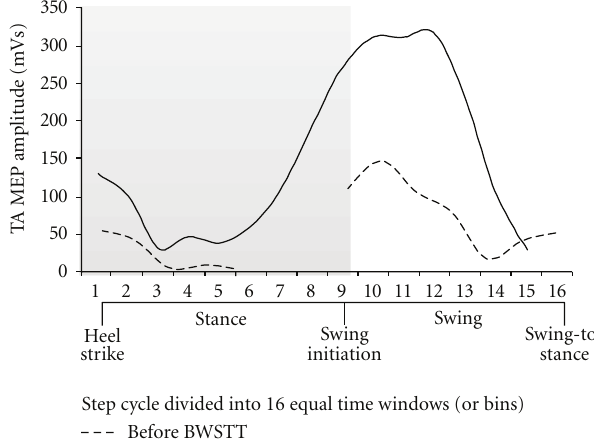
Figure 2: TA MEP modulation during stepping before and after locomotor training in SCI. The tibialis anterior (TA) motor evoked potential (MEP) amplitude before (dashed line) and after (solid line) 60 body weight-supported treadmill training (BWSTT) sessions is indicated as a function of the step cycle during body weight-supported (BWS) assisted stepping for one patient with American Spinal Injury Association (ASIA) Impairment Scale (AIS) D (49 yo female, 5 years after injury, T5–7). The TA MEP was evoked randomly every 3 to 4 steps at 1.3 times TA MEP threshold while stepping at 0.5 m/s with 50% BWS before training and at 0.89 m/s with 20% BWS after training. MEP threshold was established with subject standing at equivalent levels of BWS utilized during stepping. The step cycle was divided into 16 equal time windows or bins. Stance phase duration is identified by the grey region. Bin 1 corresponds to heel strike. Bins 8, 9, and 16 correspond approximately to stance-to-swing transition, swing phase initiation, and swing-to-stance transition,